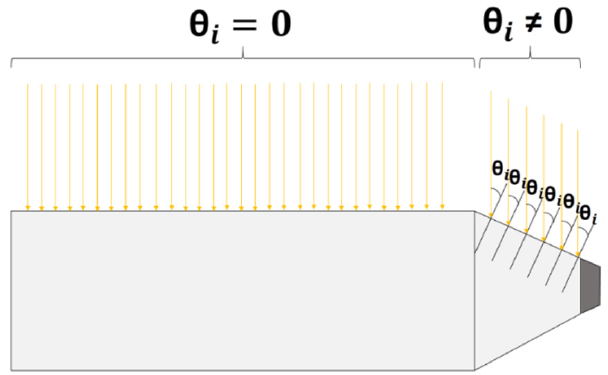
Figure 4. The incident light on the optical antenna.